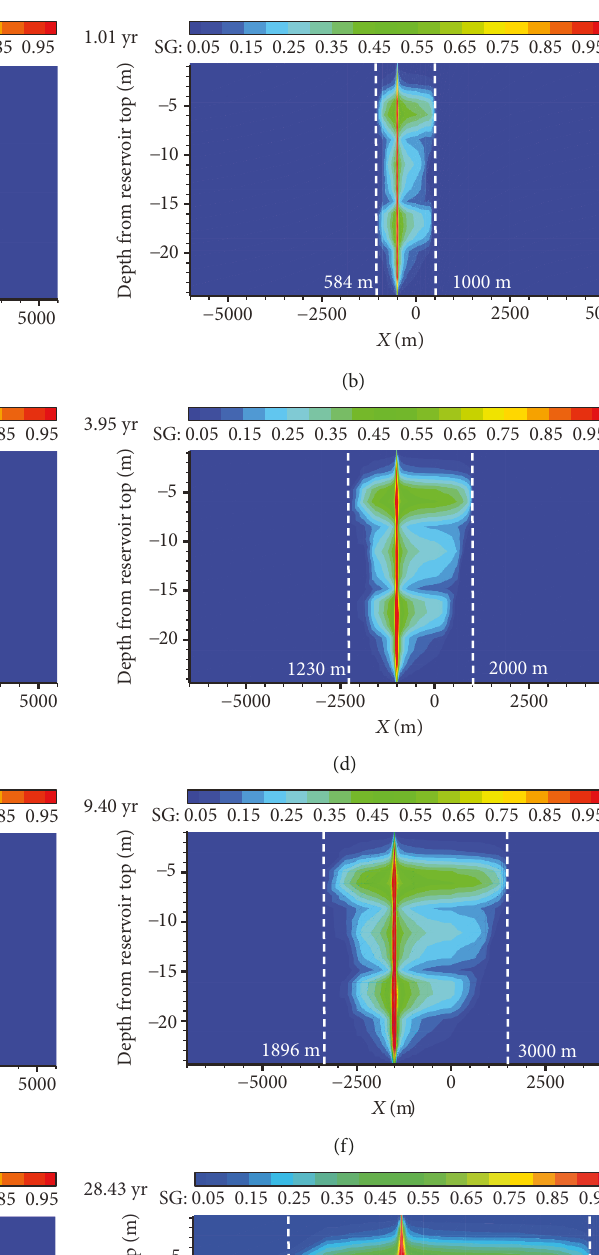
at the end of the simulation in di ff erent scenarios (analysis of the well spacing). (a) Sole 2 injection at 3.95 years.(d) The well spacing of 2 km at 3.95 2 injection at 28.43 years. (h) The well spacing 2